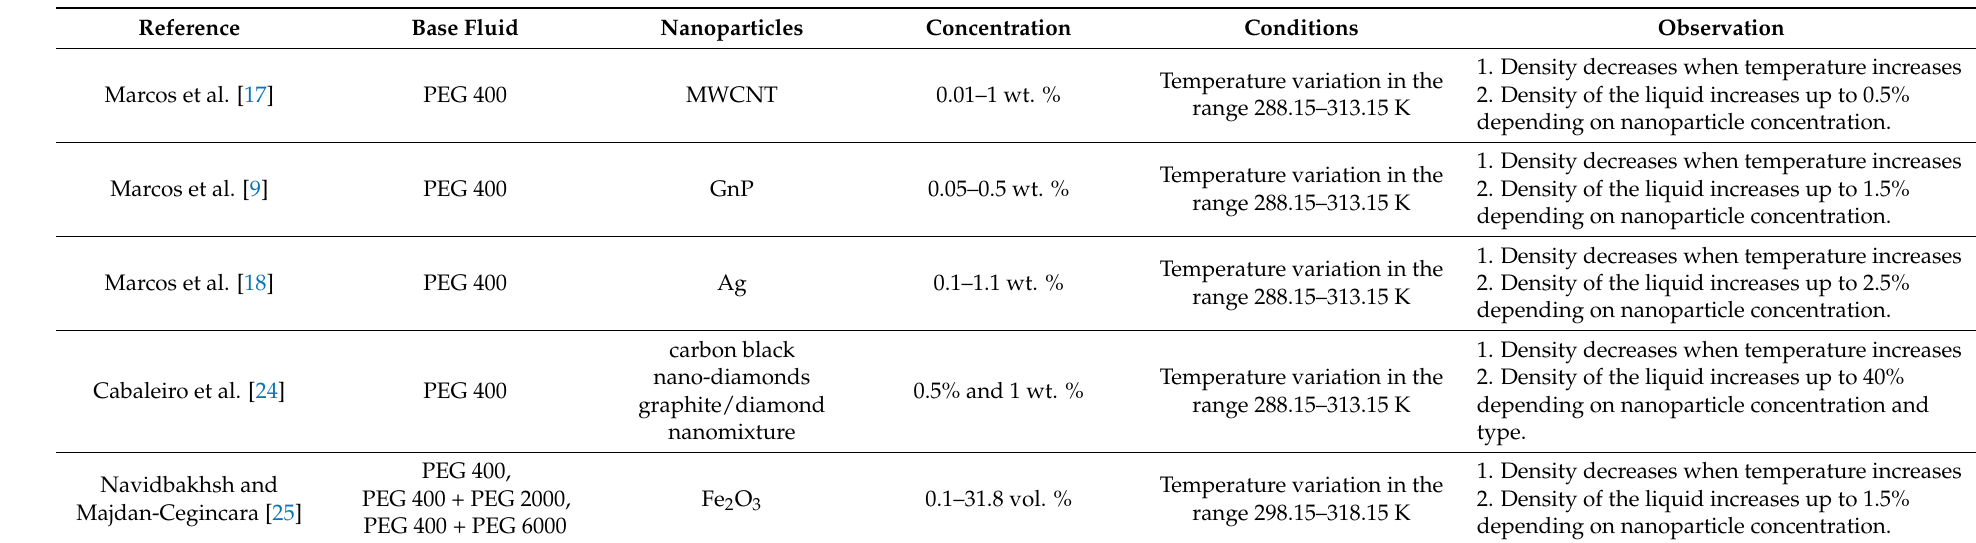
Table 4. Results for